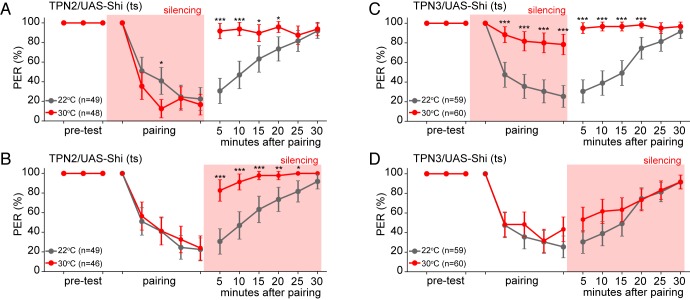
TPN2 carries the CS signal, while TPN3 carries the US signal.A and B. Aversive taste memory is impaired upon conditional silencing of TPN2 during either the pairing (A) or the testing/retrieval (B) phases, suggesting TPN2 carries the CS signal. (C) Conditional silencing of TPN3 during the pairing phase shows the inability to form a memory, suggesting TPN3 carries the US signal. (D) Conditional silencing of TPN3 during the testing phase has no impact on memory. Error bars are 95% CI; Fisher’s Exact Tests with Bonferroni adjusted alpha levels of *p<0.005 (0.05/10), **p<0.001 (0.01/10), ***p<0.0001 (0.001/10).